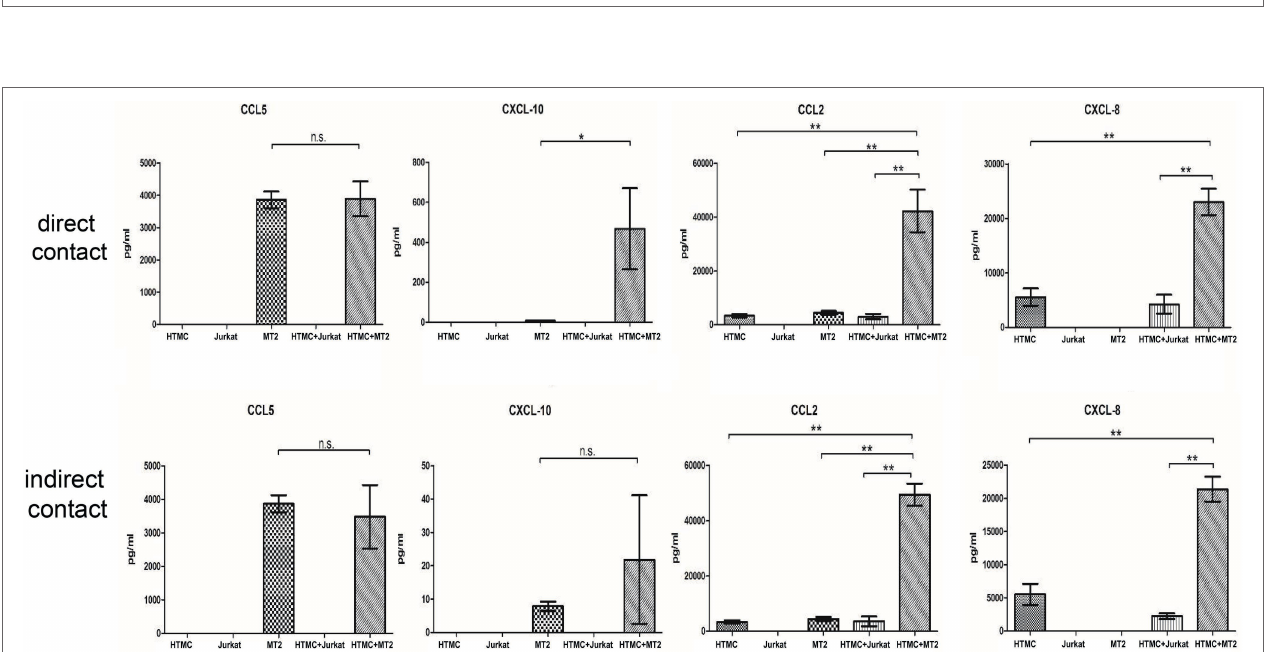
FIGURE 3 | Inflammatory cytokines secreted by HTMCs, MT-2 cells, Jurkat cells, and HTMCs co-cultured with MT-2 or Jurkat cells under conditions of direct/ indirect contact for 48 h. After co-culture with MT-2 cells, secretion of the cytokine IL-6 increased significantly. Data are taken from three independent biological experiments. Error bars represent standard deviation (units: pg./ μ l; * p < 0.05; n.s., not significant).